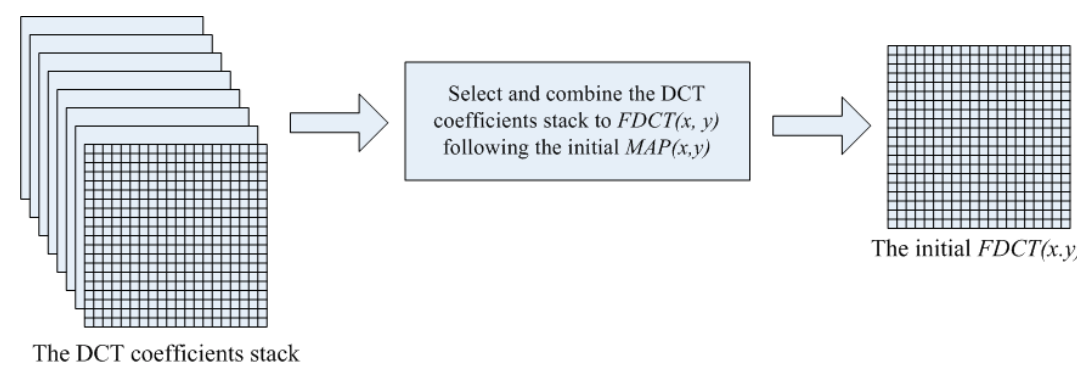
Figure 3. The initial MAP ( x , y ) process.